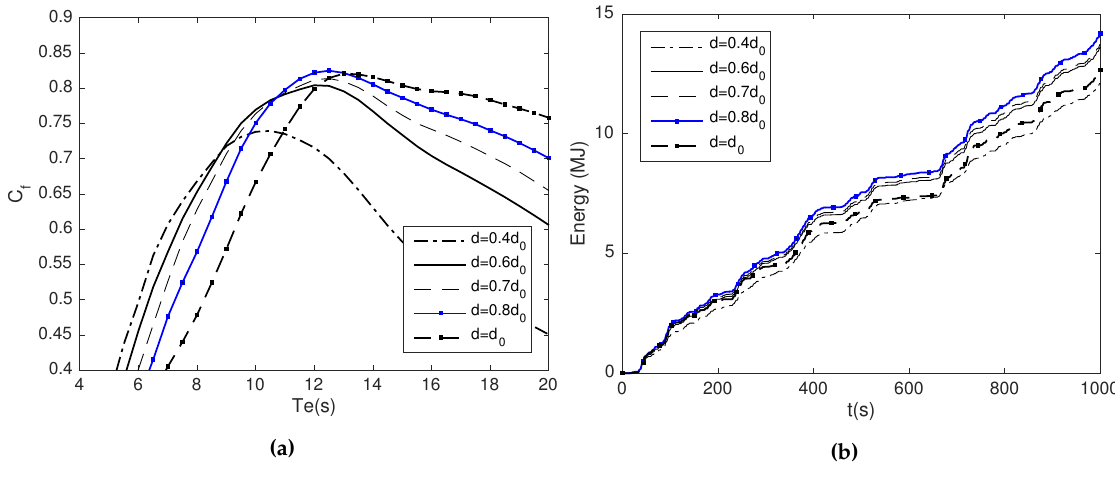
Figure 18. ( a ) C f variation with T e s for varies values of d s without any controller; ( b ) Cumulative energy capture at T e = 12 s by varying the chamber